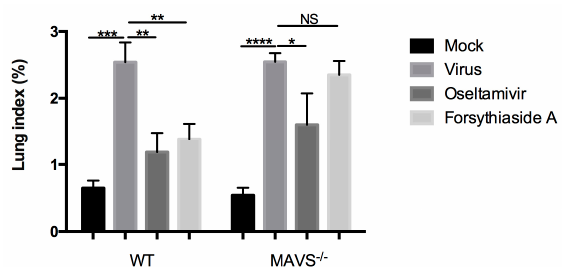
Figure 3. Effects of forsythiaside A on lung index of influenza virus-infected mice. At day 6 post infection, the mice were sacrificed, and the lungs were completely resected. Lung index = lung weight/body weight × 100%. ( n = 6) * p < 0.05, ** p < 0.01, *** p < 0.001, NS, p > 0.05.